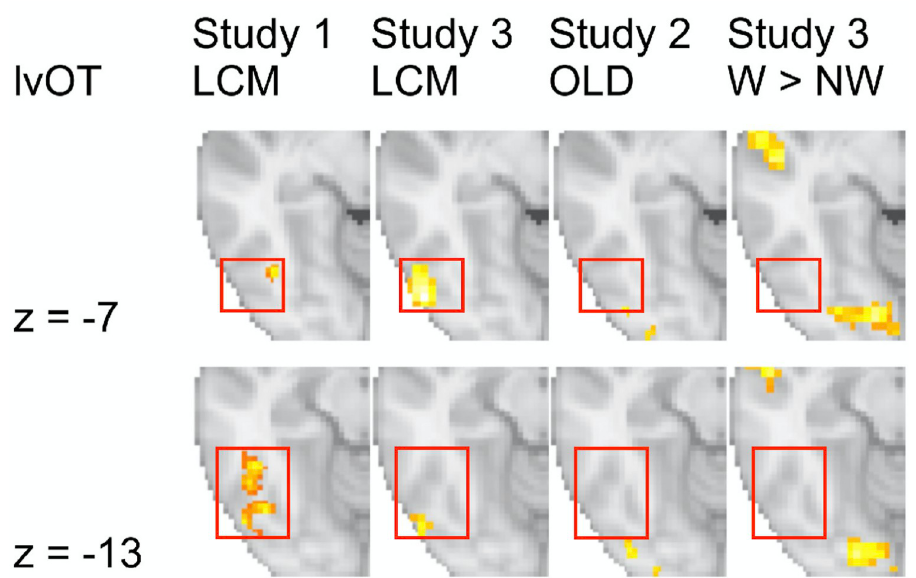
Fig 4. Comparison of BOLD activation across studies and contrasts. Significant LCM activation clusters in the lvOT across studies show some overlap, but no overlap to word-likeness and lexicality contrasts. Thresholds for all whole brain analyses: voxel level: p < .001 uncorrected (cluster-forming); cluster level: p < .05 family-wise error